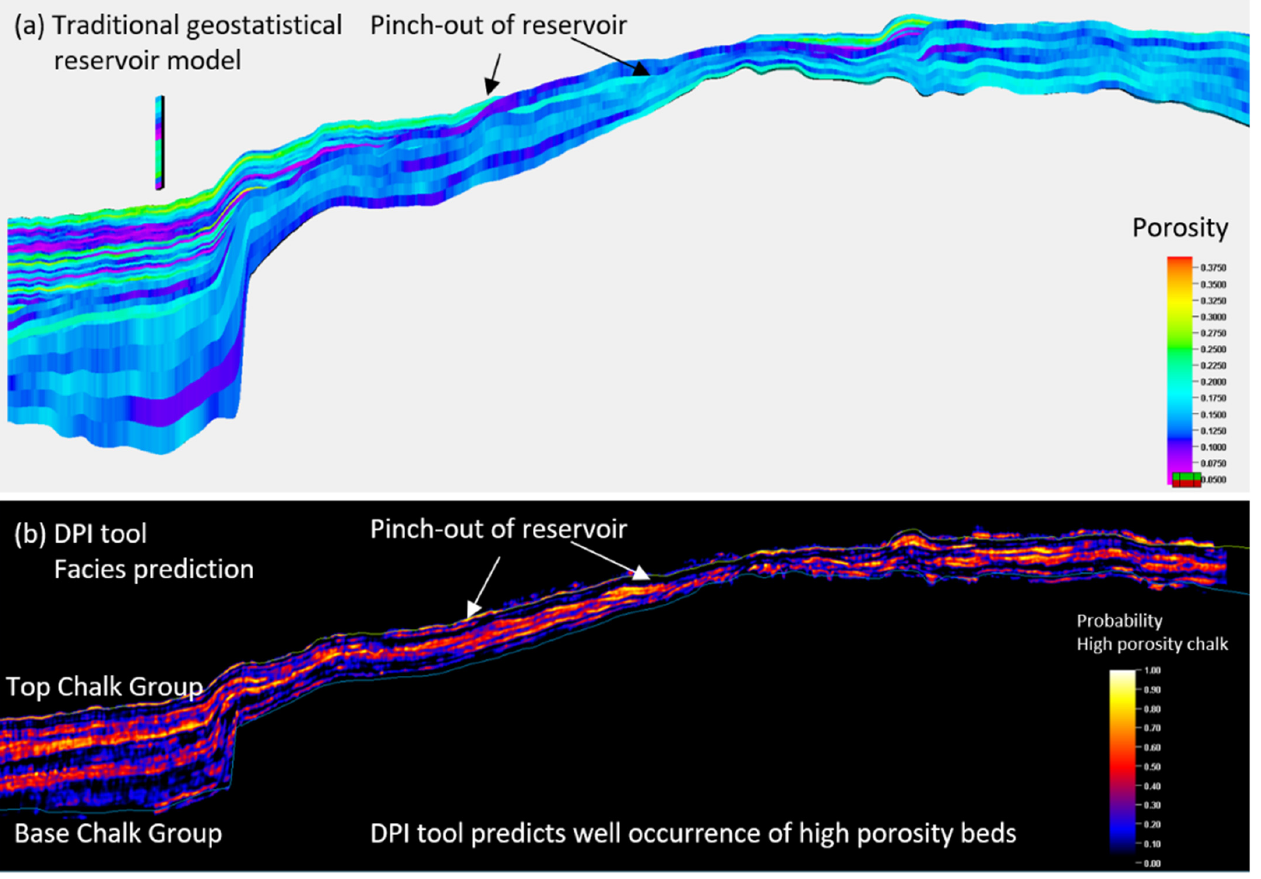
Figure 18. Comparison of ( a ) traditional geostatistical reservoir modeling method, extrapolating data from well logs; and ( b ) prediction of high-porosity chalk facies from the DPI tool.